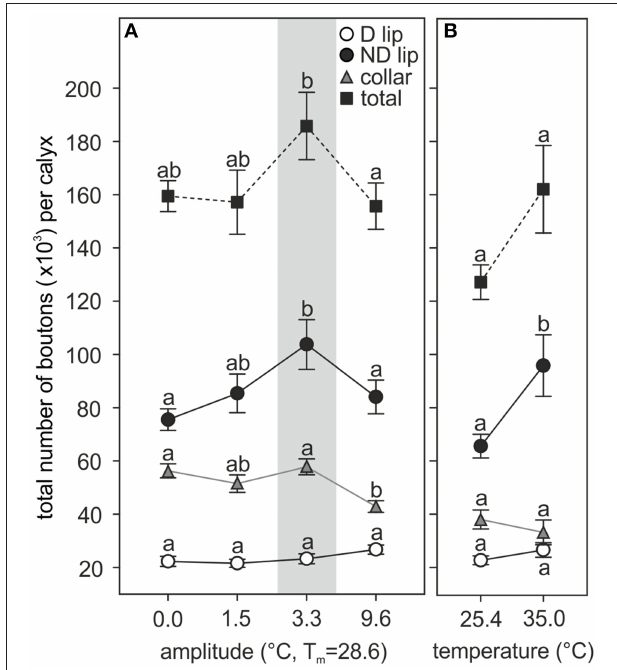
FIGURE 5 | Pupal thermal experience effects on the number of MB calyx synaptic boutons in the adult brain. Pupae reared at (A) different amplitudes of fluctuating temperature but the same mean temperature or (B) different constant temperature regimes. Number of synaptic boutons per calyx in the D lip, ND lip, collar, and the sum of all three regions (total number of boutons per calyx). Gray area shows the temperature regime selected by nurses for brood translocation. Symbols represent the mean value of each group and lines the S.E. Different letters indicate significant differences among amplitudes or between constant temperatures. D and ND lip: N 0 = 13 , N 1.5 = 9 , N 3.3 = 10 , N 9.6 = 11 , N 25.4 = 11 , N 35 = 10 ; collar: N 0 = 10 , N 1.5 = 8 , N 3.3 = 11 , N 9.6 = 9 , N 25.4 = 11 , N 35 = 9 ; total: N 0 = 10 , N 1.5 = 8 , N 3.3 = 10 , N 9.6 = 9 , N 25.4 = 11 , N 35 = 9